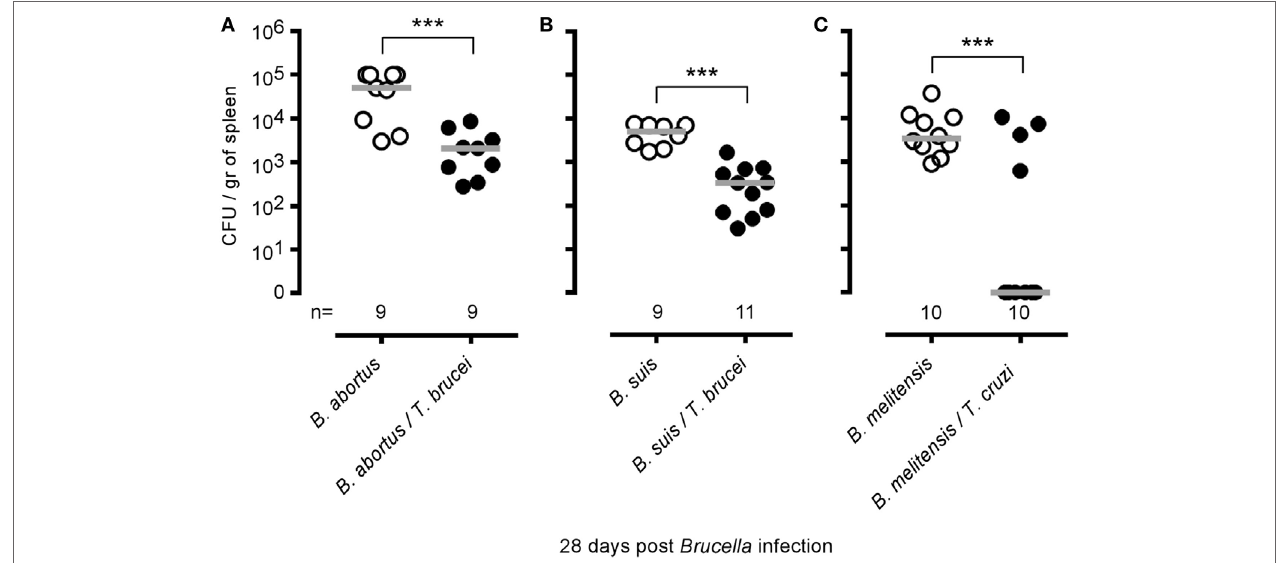
FigUre 4 | Impact of Trypanosoma brucei co-infection on Brucella suis and Brucella abortus infection and impact of Trypanosoma cruzi on Brucella melitensis infection. Wild-type C57BL/6 mice were infected i.n. with 2 × 10 4 CFU of B. abortus (a) or B. suis (B) and, at 7 days postinfection, received an i.p. injection of 5,000 T. brucei in 200 µl of PBS or PBS alone. (c) Wild-type C57BL/6 mice were infected i.n. with 2 × 10 4 CFU of mCherry- B. melitensis and, at 7 days postinfection, received an i.p. injection of 1,000 T. cruzi in 200 µl of PBS or PBS alone. The mice were euthanized at 28 days post Brucella infection, and the spleen was harvested. The data represent the number of colony-forming units per gram of spleen. Gray bars represent the median. n denotes the number of mice used for each group. These results are representative of at least two independent experiments (*** p <